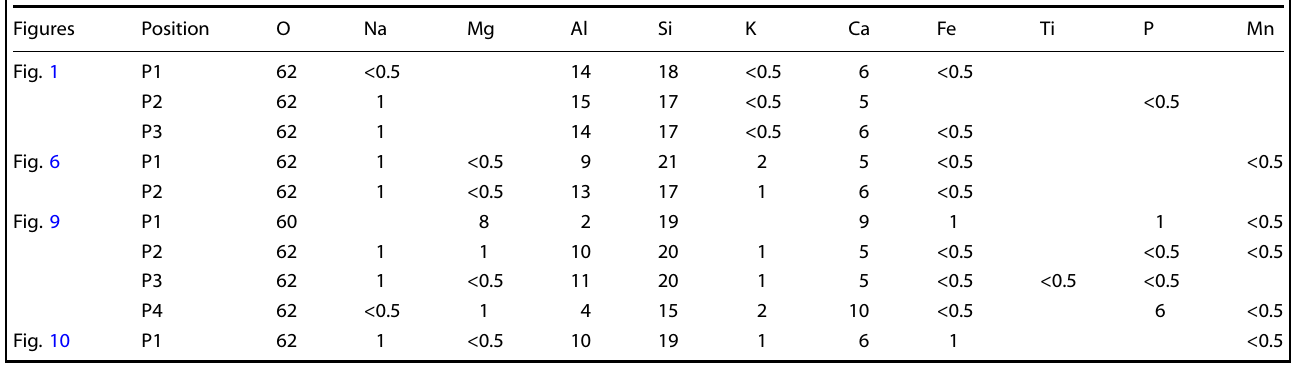
Table 2. Chemical compositions of the marked positions (crystalline phase) shown in Fig. 1, Fig. 6, Fig. 9, and Fig. 10 (in atom%). Figures Position Fig. 1